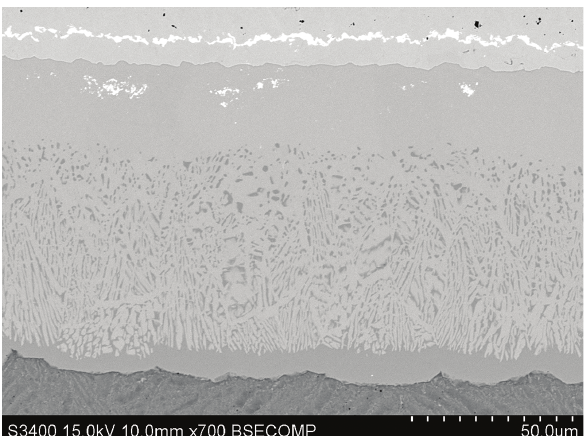
Figure 2: The SEM microphotography of diffusion in Ni – Ti system after 200 h at 1,123